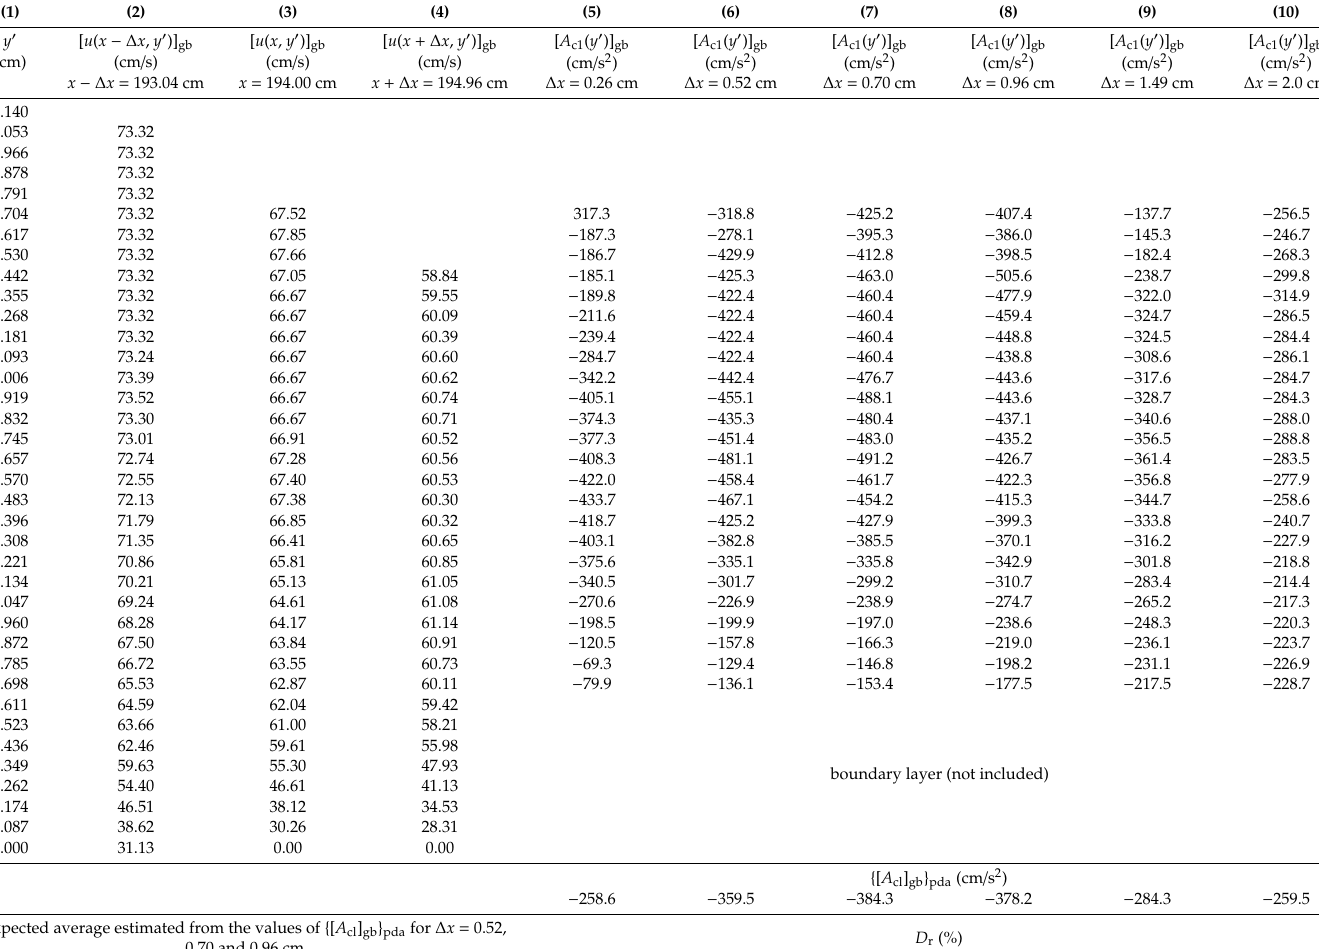
Table A2. List of velocity data at di ff erent sections for t = 2.069 s and calculation of first convective acceleration [ A c1 ( y (cid:48) )] gb for t = 2.069 s with six di ff erent spatial intervals. Note that partially depth-averaged values of first convective acceleration {[ A cl ] gb } pda and their relative deviations D r are presented at the bottom of the